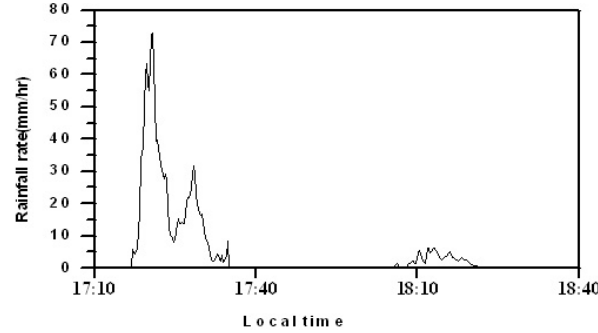
Fig. 4. Rainfall measurements as observed on 18 August